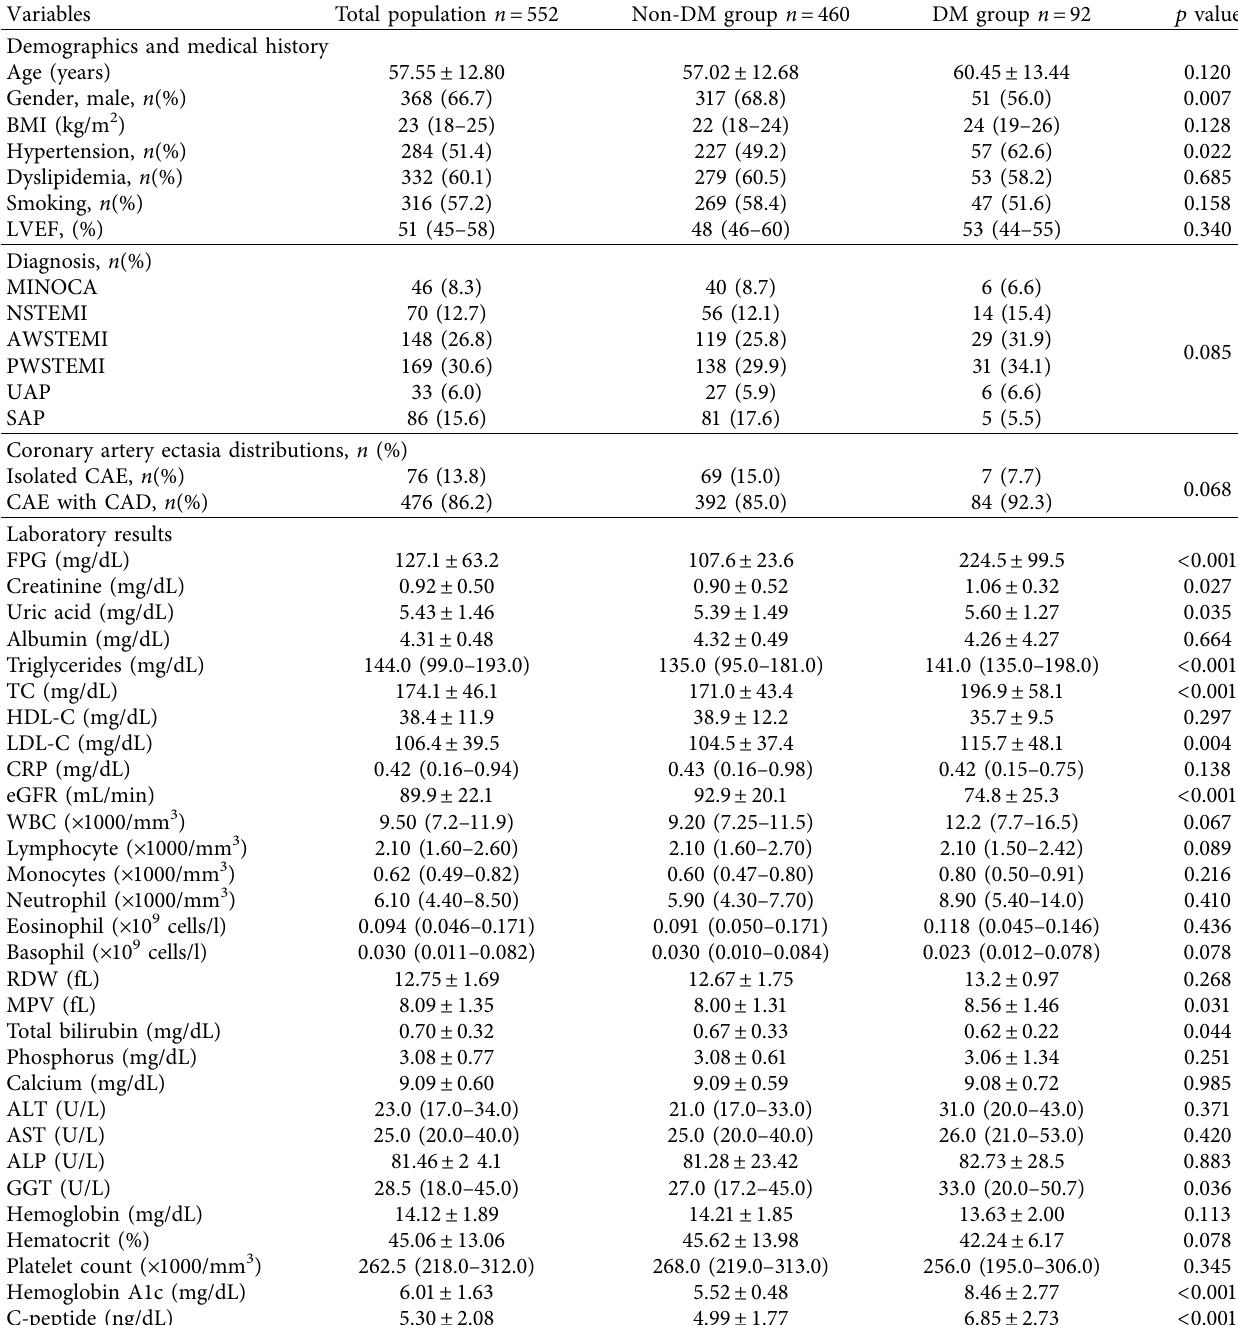
Table 3: Baseline characteristics of coronary ectasia patients according to their diabetic